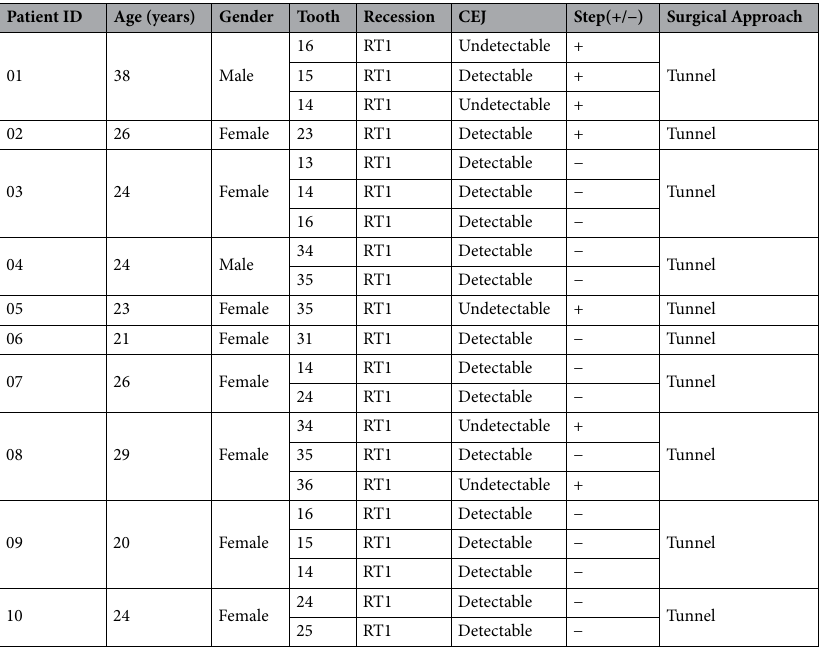
Table 1. Patients’ and site-specific characteristics for the tunneling technique. Recession Cairo’s recession classification, CEJ cementoenamel junction, Class A detectable CEJ, Class B undetectable CEJ, Step root surface concavity, + presence of a cervical step, − absence of a cervical